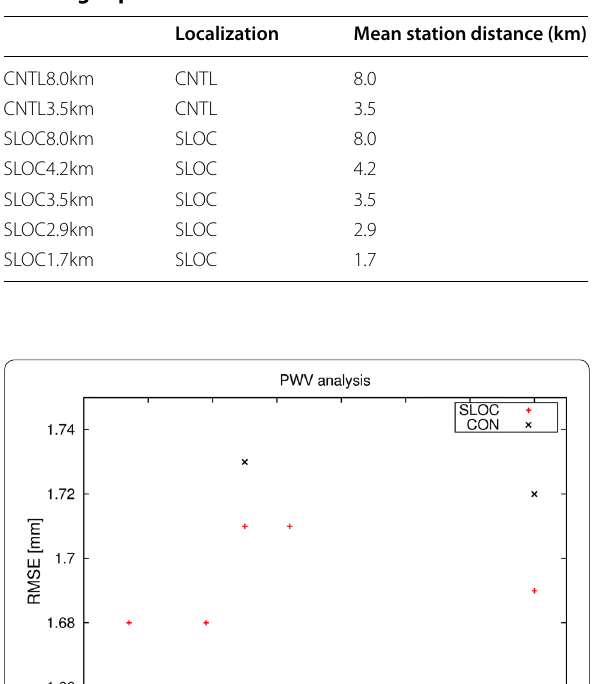
Table 2 Code for each experiment and the settings of the thinning experiments